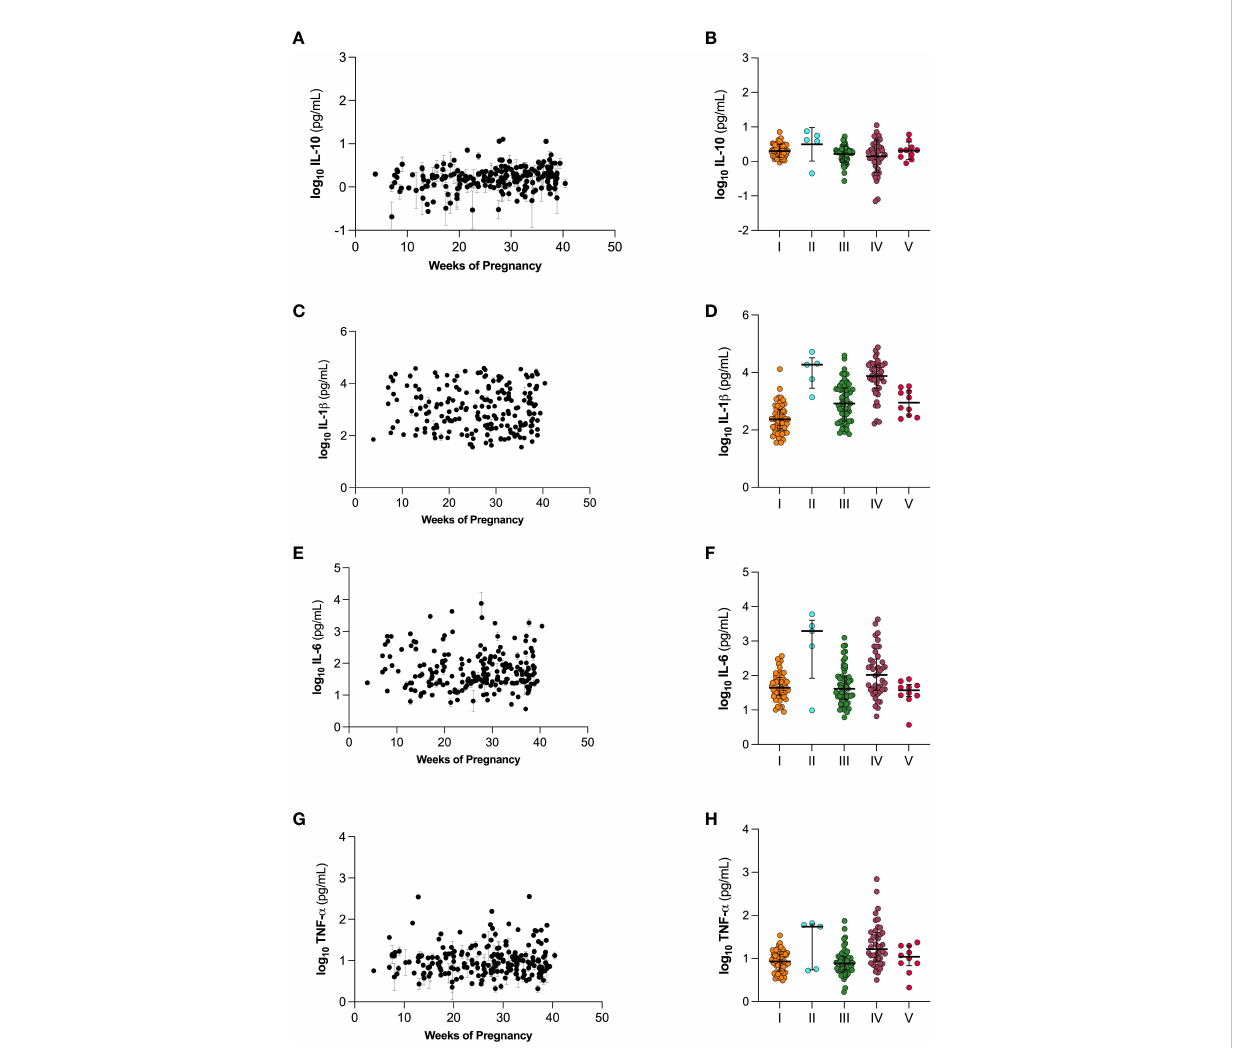
FIGURE 6 Cytokine levels over the course of gestation (A, C, E, G) and separated by vaginal microbiome CST (B, D, F, H) . (A, B) IL-10, (C, D) IL-1 b , (E, F) IL-6, and (G, H) TNF- a . Individual datapoints in (A, C, E, G) are shown as mean ± SEM based on technical replicates. Data in (B, D, F, H) are shown as mean ±